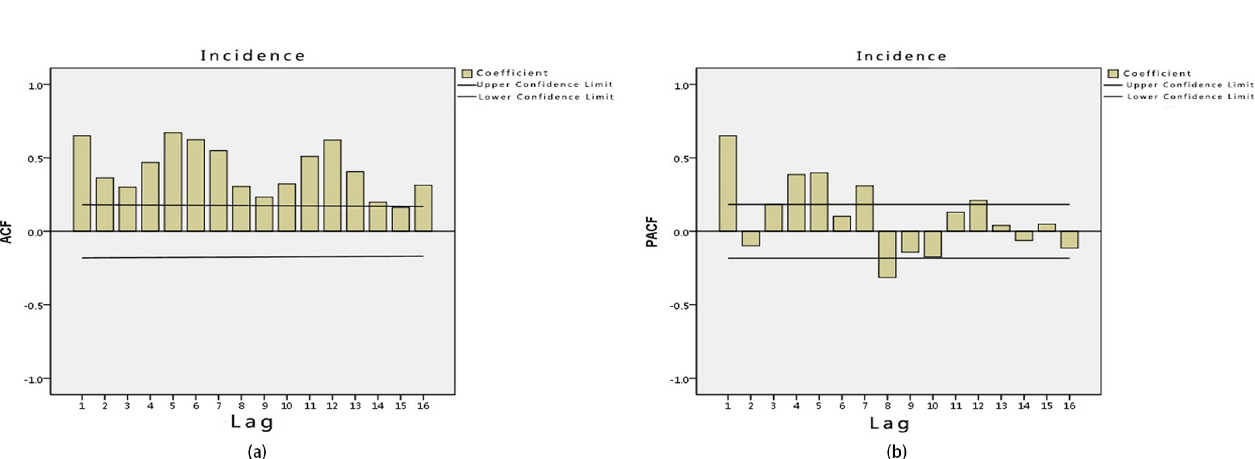
Fig 4. Correlation function values for the HFRS incidence data in Hubei Province from 2005 to 2014. (a) Autocorrelation (b) Partial autocorrelation. The ACF (autocorrelation function) values for HFRS incidence in each lag.